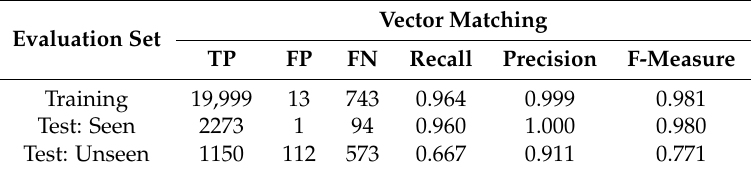
Table 5. Instance detection results for the training set (1600 images), the test set with images of the same environments in the training set (200 images), and the test set with images of new environments and challenging lighting conditions (200 images). The part detection threshold was fixed at 0.25. Vector Matching Evaluation Set TP FP FN Recall Precision F-Measure Training 19,999 13 743 0.964 0.999 0.981 Test: Seen 2273 94 0.960 1.000 0.980 Test: Unseen 1150 573 0.667 0.911